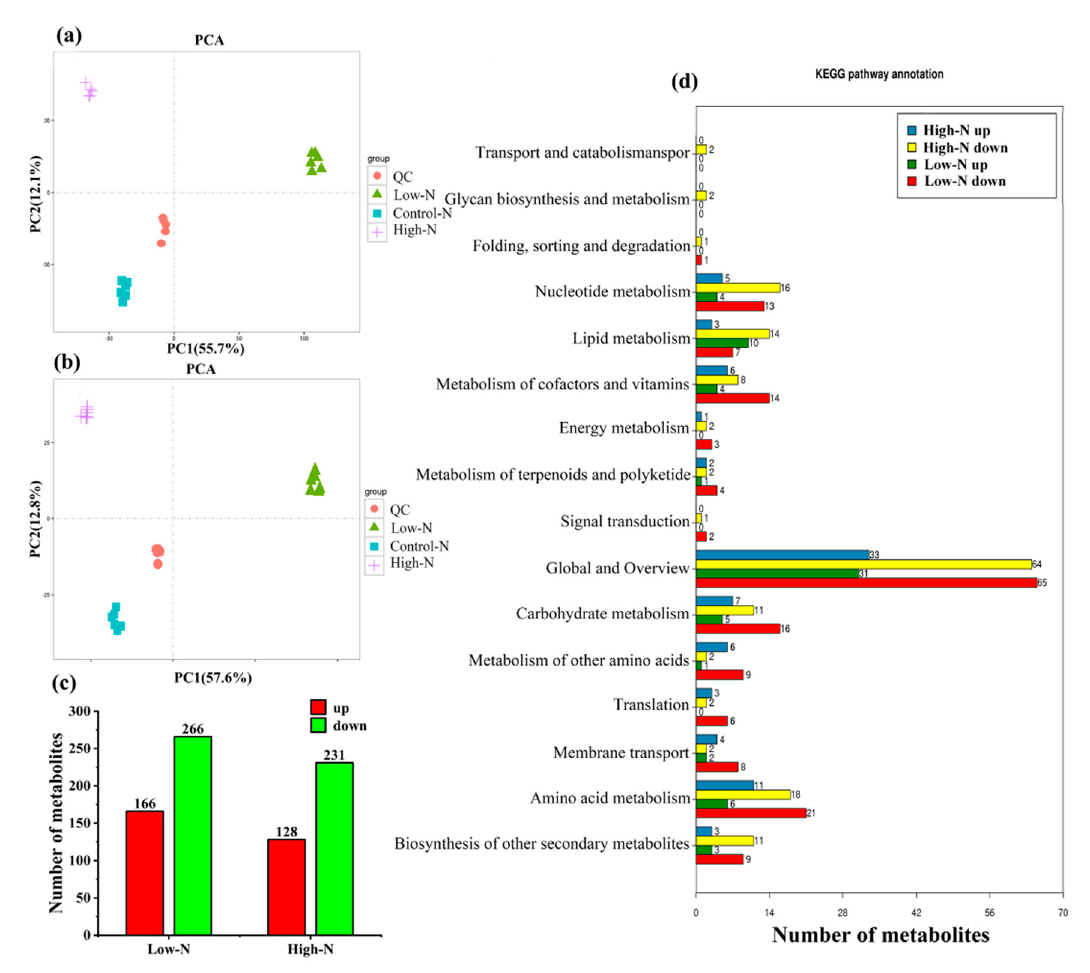
Figure 1. Metabolic analysis of rice leaves under low N and high N: Test samples and quality control samples principal component analysis in ( a ) positive and ( b ) negative ion mode; ( c ) the total number of different metabolites, upregulated and downregulated, under low N and high N; ( d ) Kyoto Encyclopedia of Genes and Genomes (KEGG) analysis of the differentially changed metabolites.